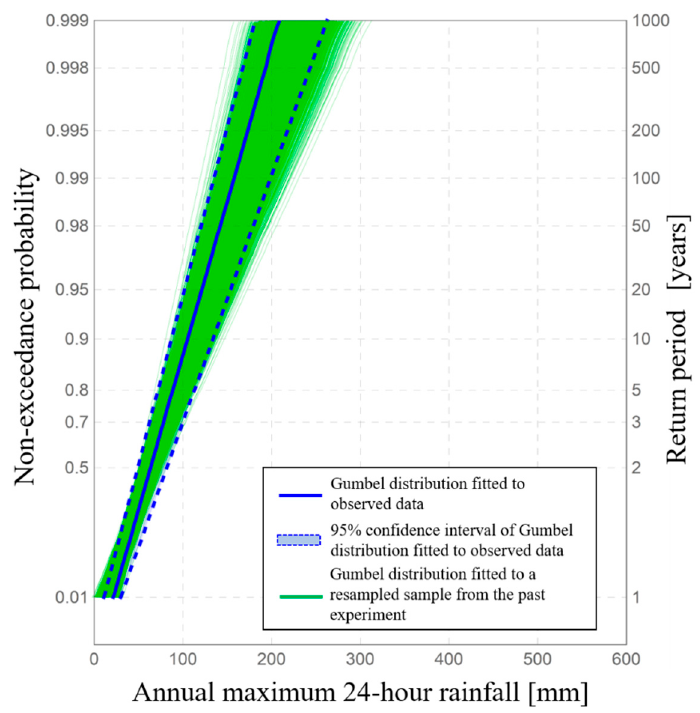
Figure 13. 95% confidence interval based on probability limit method test for past climate and Gumbel distributions fitted to each of the 5000 resampled samples of past experiment.